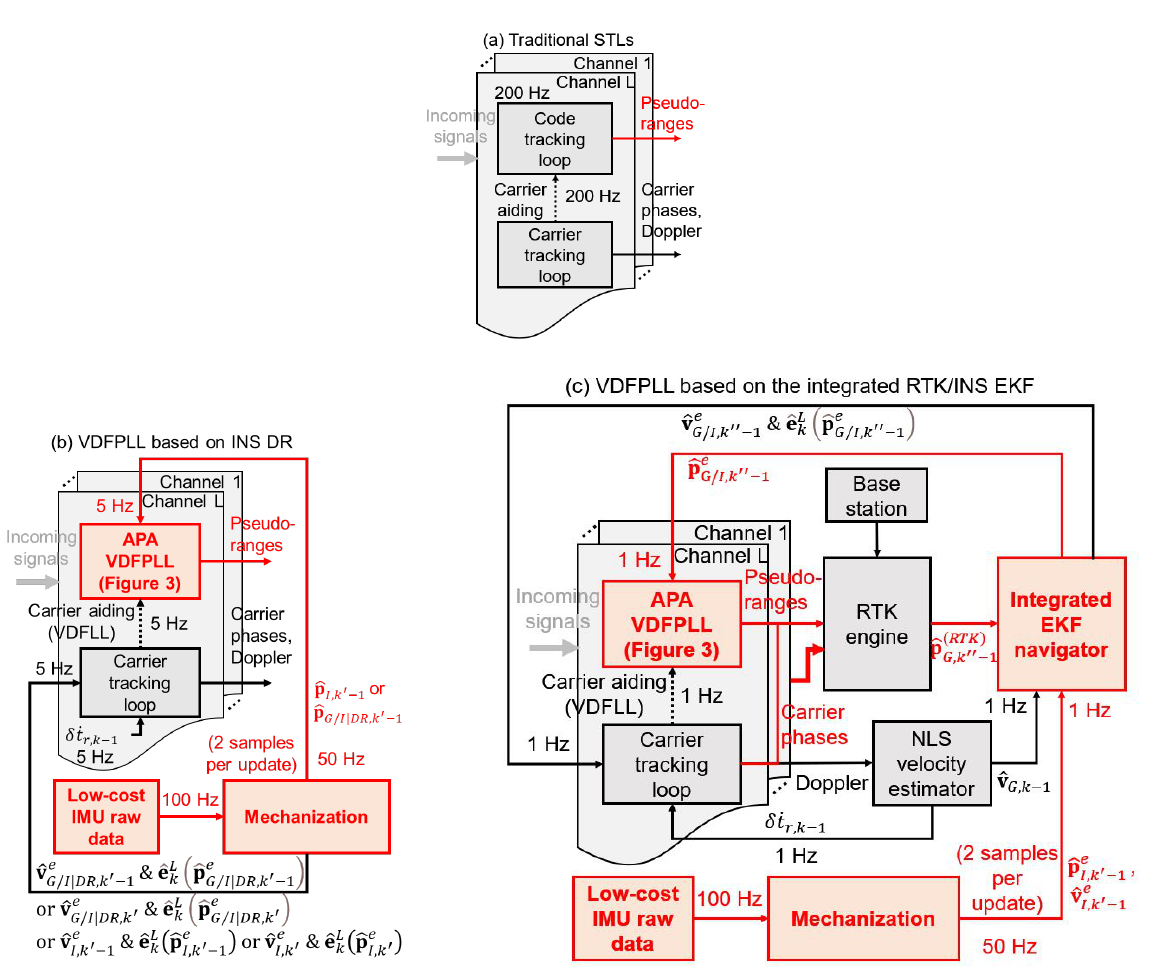
Figure 4. Architecture of the proposed VDFPLL-enhanced GPS SDR based on the deep integration of float RTK solutions and INS DR navigation results (detailed discussions refer to the Algorithm